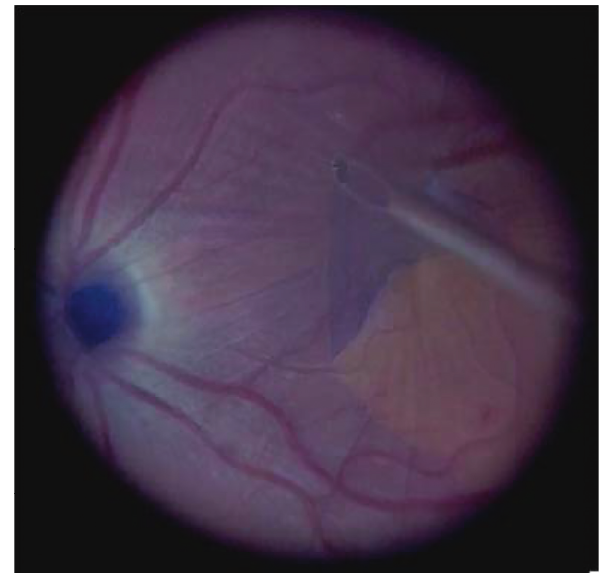
Figure 5: Internal limiting membrane peeling after brilliant blue staining after ERM